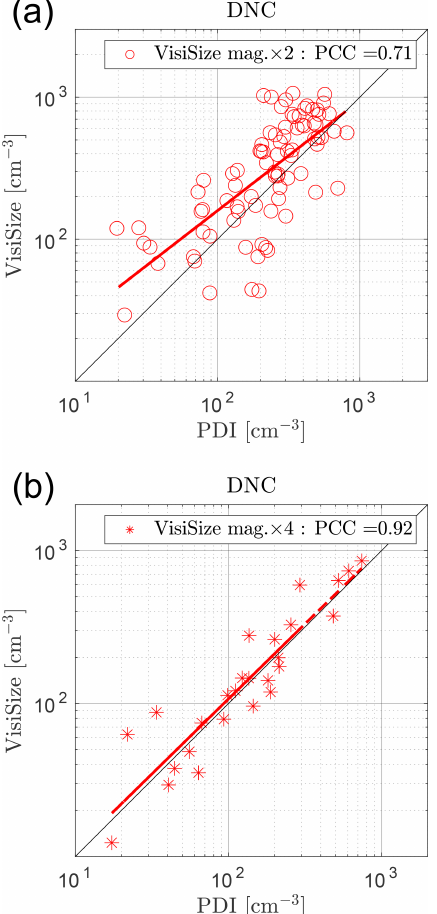
Figure 11. The DNC comparison between the two instruments, with cases using different lens magnification settings for the VisiSize ( a : × 2 and b : × 4), plotted separately. The results after applying all modifications and filters to the data, and application of the PVC fac- tor to the modified PDI swept volume method, are shown here. Each circle/star represents a single measurement of ∼ 15min. Dashed red lines show the LSR, and the PCC is shown in the legend.